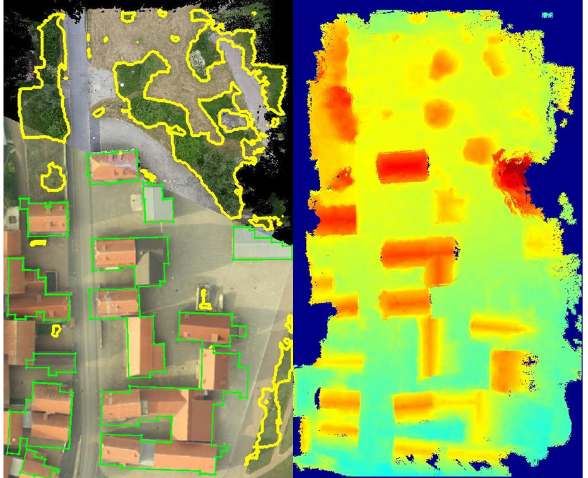
Figure 2: Left: Reference image with building outlines (green) and vegetation areas (yellow) obtained by our method for the data set Bonnland . Right: the corresponding elevation